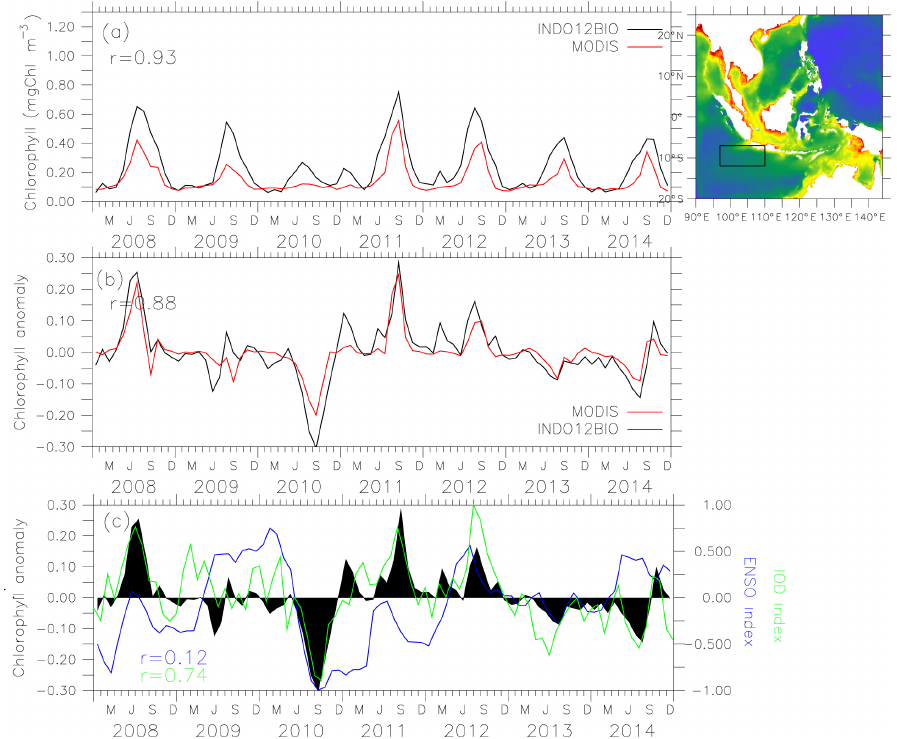
Figure 9. Same as Fig. 7, in the Sunda area.